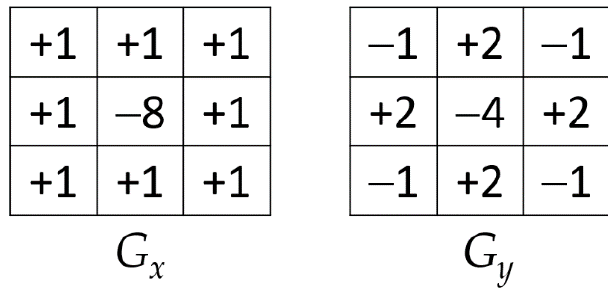
Figure A6. 3 × 3 masks of LOG-ED.